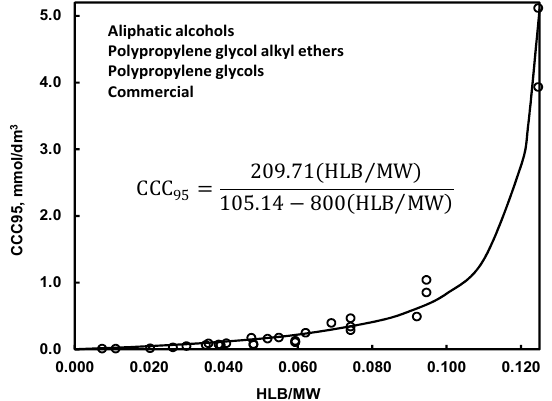
Figure 6. Relation between CCC and HLB/MW [42].